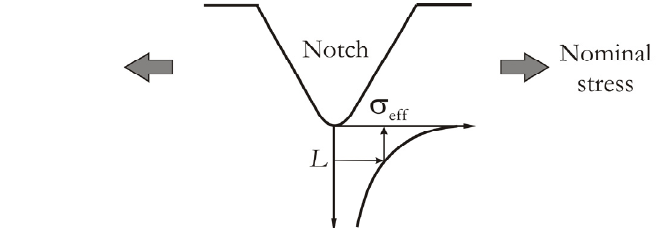
Figure 3: Schematic representation of the Point